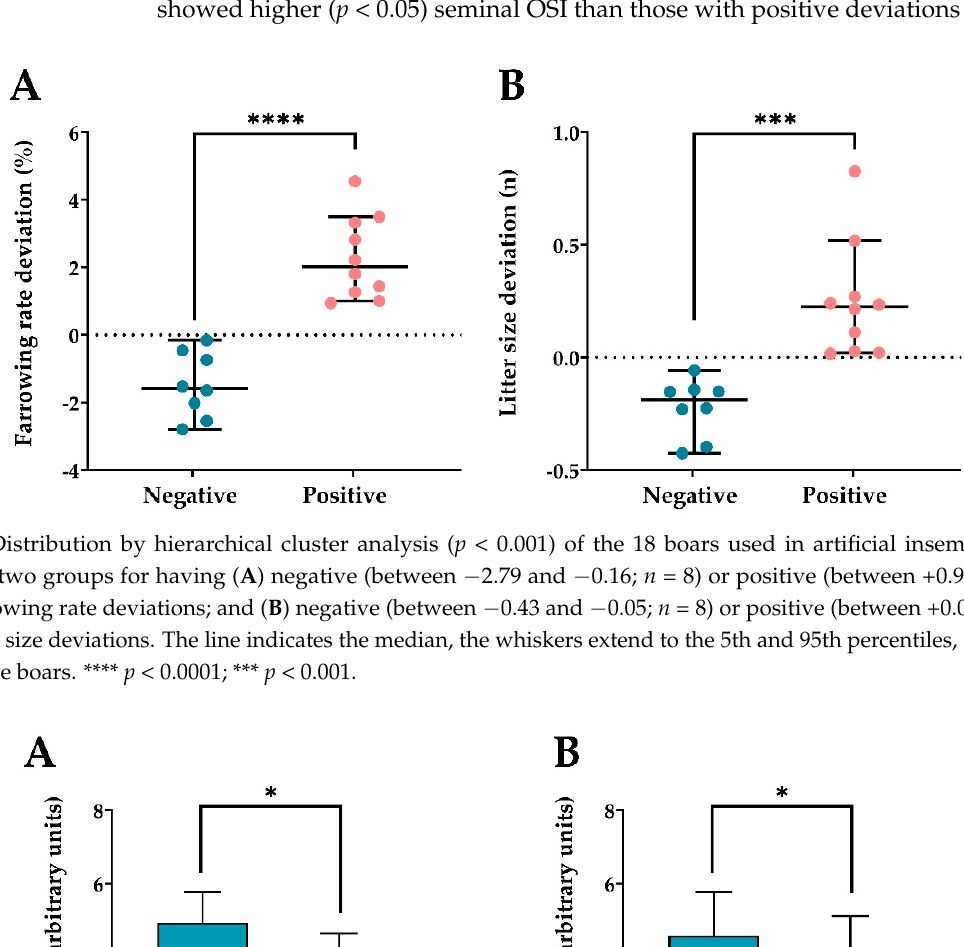
7 of 13 of the same genetic line. The deviation ranged between +4.54 and − 2.79 for the farrowing rate and between +0.83 and − 0.43 for the number of piglets born per farrowing. The OSI values of the 72 seminal plasma samples (four per boar) ranged from 0.81 to 7.42. The correlation coefficient of Pearson evidenced that seminal OSI was weakly related with farrowing rate deviation ( p < 0.05; R= − 0.54) and was not related with litter size deviation ( p > 0.05; R = − 0.34). Then, the 18 AI-boars included in this study were hierarchically clus- tered ( p < 0.001) into two groups as having either a negative (ranging from − 2.79 to − 0.16; n = 8) or positive (ranging from +0.94 to +4.54; n = 10) farrowing rate deviation (Figure 3A). Similarly, the boars were also clustered into two groups as having either negative (ranging